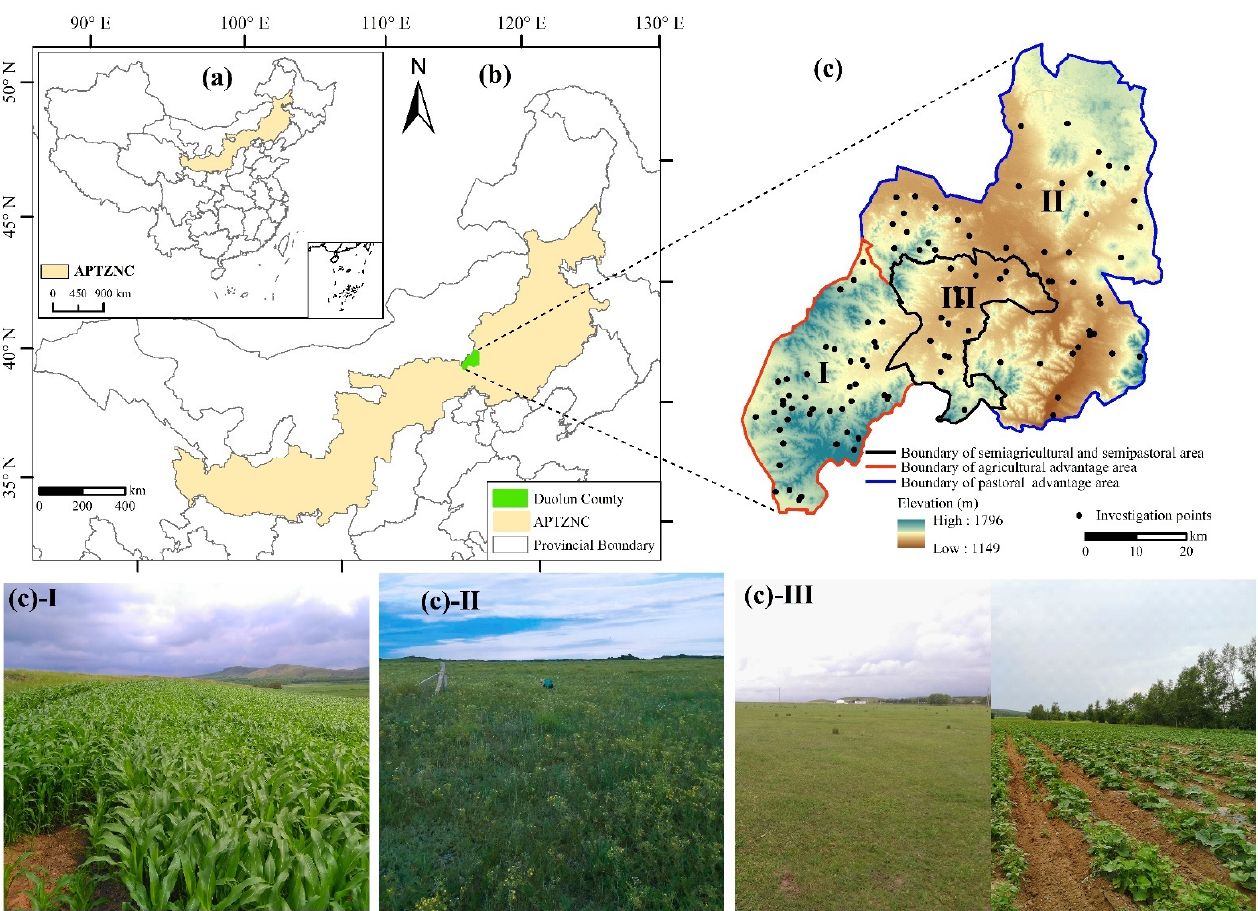
Figure 1. Locations in the study area and general description of geographical information: ( a ) the location of the APTZNC in China; ( b ) the location of Duolun County in the APTZNC; ( c ) a digital elevation model (DEM) of the study area; ( cI ) survey photographs of the agricultural advantage zone (agro-zone); ( cII ) survey photographs of the pastoral advantage zone (pastoral zone); and ( cIII ) survey photos of the semiagricultural and semipastoral zone (agro-pastoral zone). Duolun County has a temperate continental arid climate with annual precipitation of